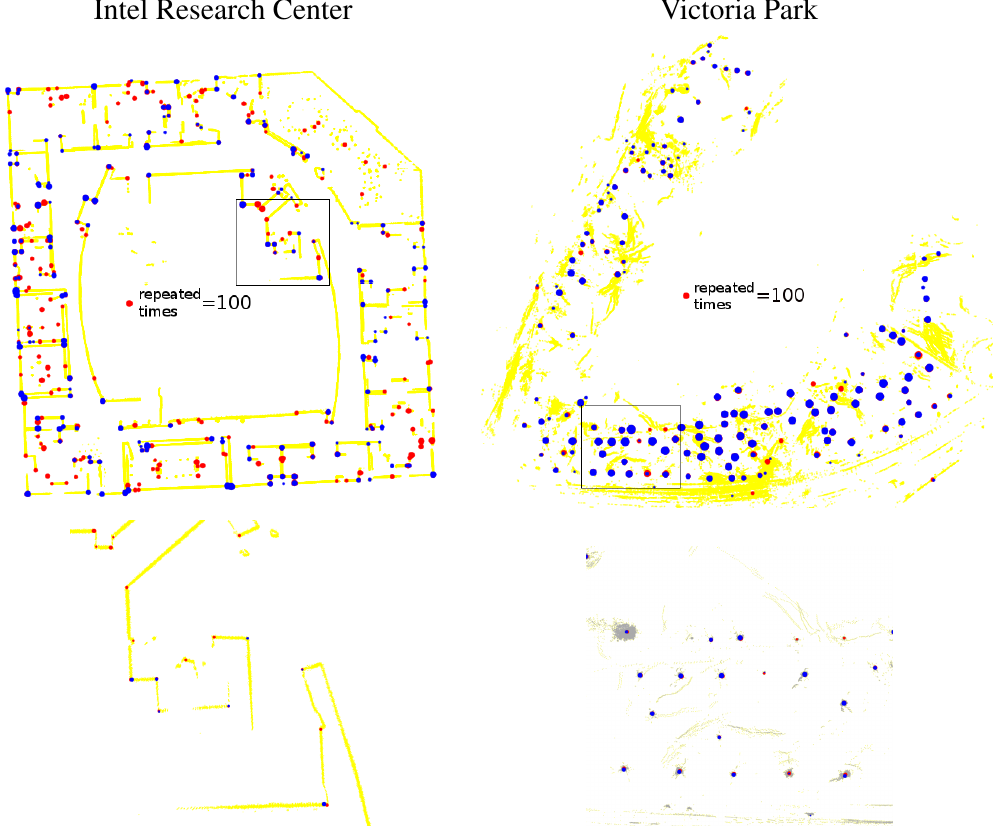
Figure 9. Repeatability. Top: the locations of detected features are shown; the size of each marker represents the number of re-observations (large dots denote often-reobserved features). Bottom: larger views of the framed parts of the top figures. The proposed method matches or exceeds the performance of the corner and tree detectors even in the environments for which those detectors were designed. While the performance of the corner and tree detectors is very poor in the “wrong” environment, the proposed method is robust in both